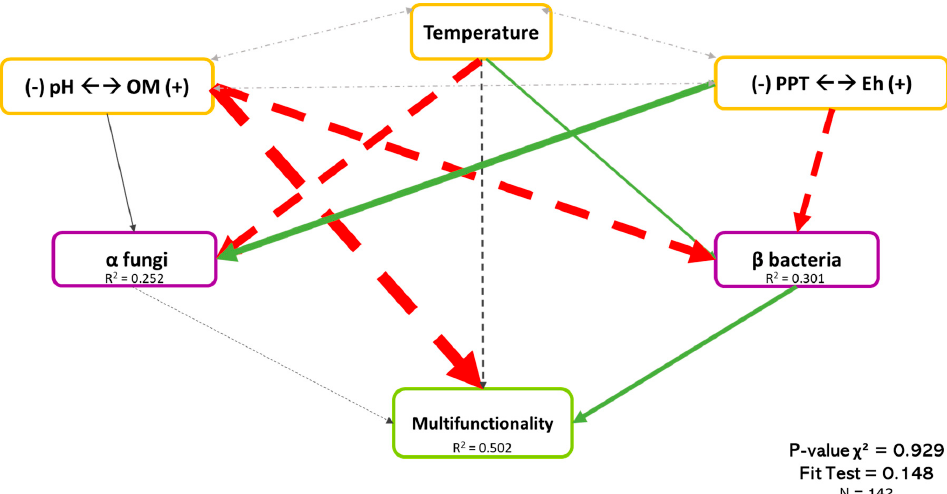
Figure 7. Causal relationships between abiotic variables, microbial diversity, and multifunctionality. Structural equation model of boreal forest ecosystems in Quebec. The direction of the arrows indicates the direction of the regression existing between the variables. The solid (green) arrows represent a positive correlation, while the dotted (red) arrows represent negative correlations ( Supplementary Material Table S3.3 ). The small pale gray arrows show the covariation. The black arrows are the nonsignificant correlations at a threshold of 0.1. The thickness of these arrows represents the strength of the correlation. The R 2 shows the proportion of variance explained for each variable and the model (cid:48) s P-value and fit test indicate the acceptability of the model. n = 142